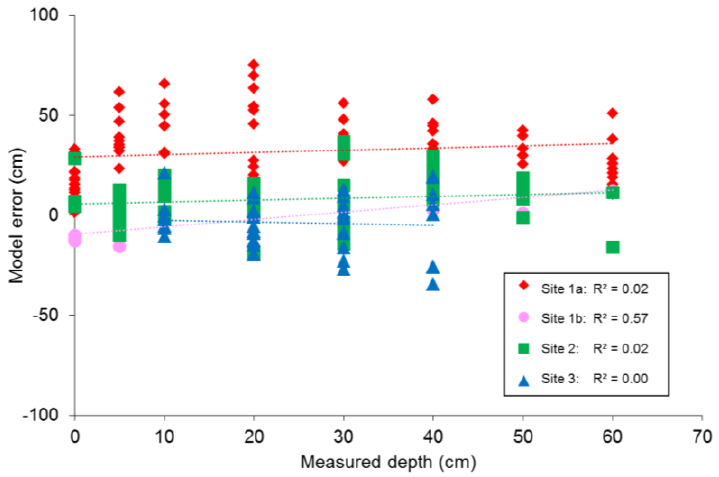
Figure 8. Scatter diagram of measured depth versus NIR(R72) model error for samples from site 1a (♦; n = 14,), site 1b (●; n = 84, validation data only), site 2 (■; n = 47) and site 3 (▲; n =